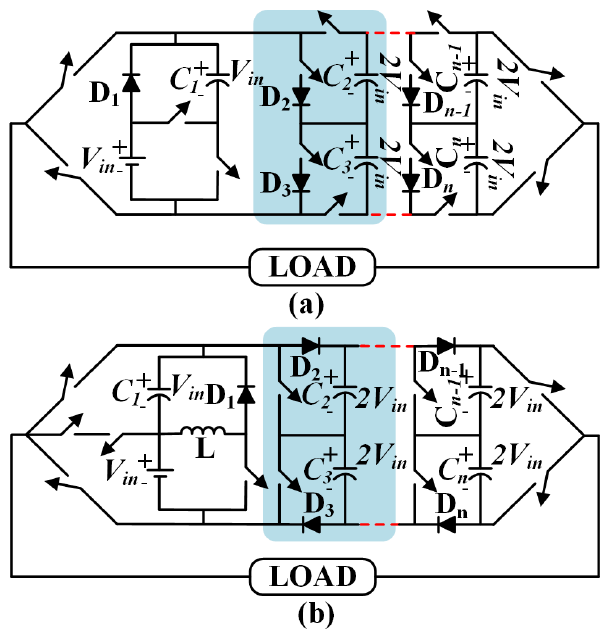
Figure 5. Representation of extended proposed topology ( a ) Topology 1 [1], ( b ) Topology